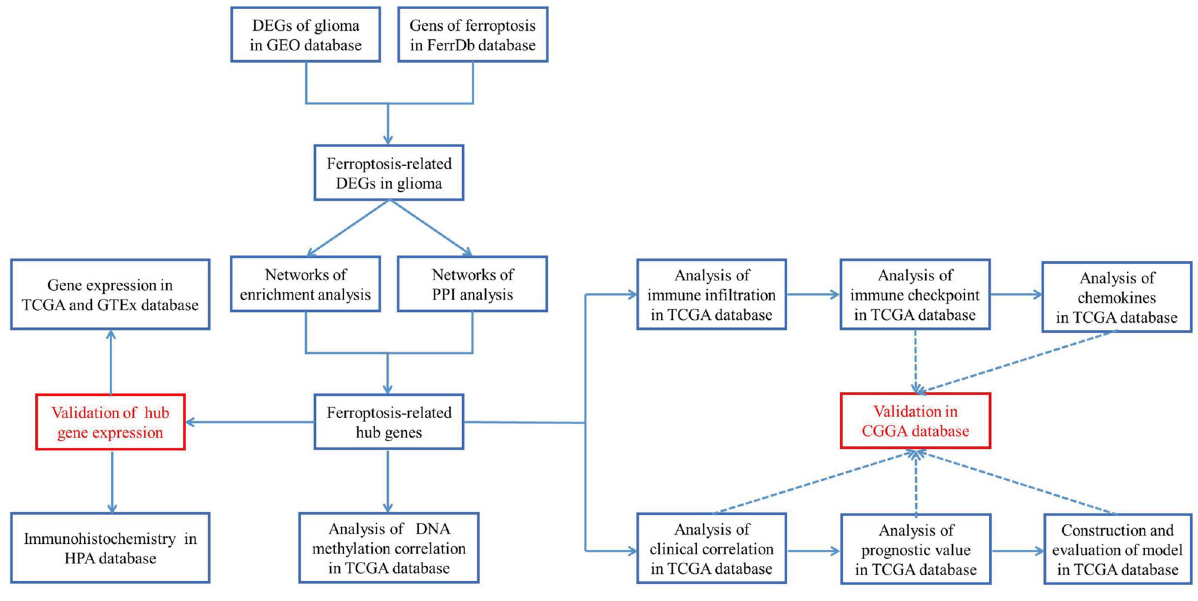
Figure 1. The flow chart of the present study